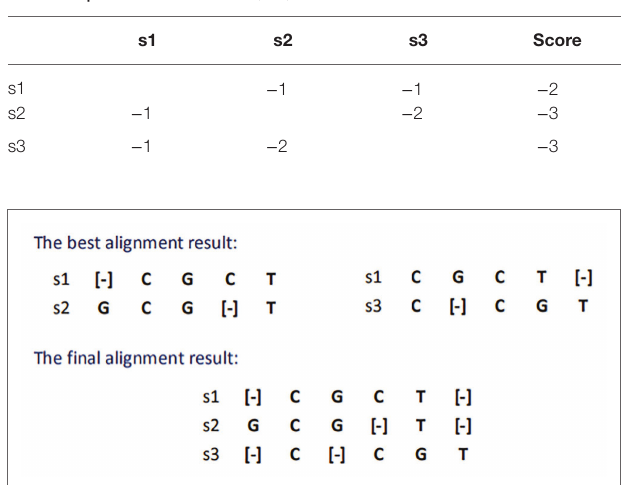
TABLE 1 | Distance matrix of s1, s2, and s3.